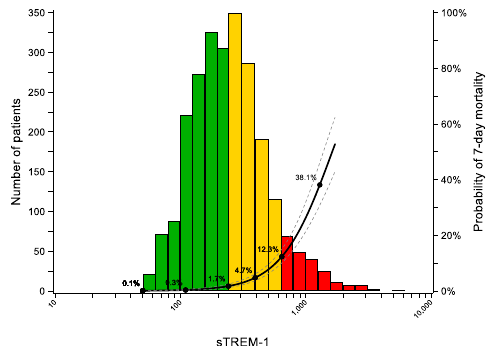
Fig. 2 Distribution of sTREM-1 at presentation with predicted probability of 7-day mortality in the combined cohort. Histogram refers sTREM-1 distribution. Negative and positive Likelihood Ratios (LRs) in the derivation and validation cohorts combined were used to risk-stratify febrile children: “ green ” zone: low risk (LR − of 0.10, sTREM-1< 239 pg/mL), “ yellow ” zone: refer and monitor (sTREM-1 ≥ 239 pg/mL and <629 pg/mL), “ red ” zone: urgent admission/support (LR + of 10, sTREM-1 ≥ 629